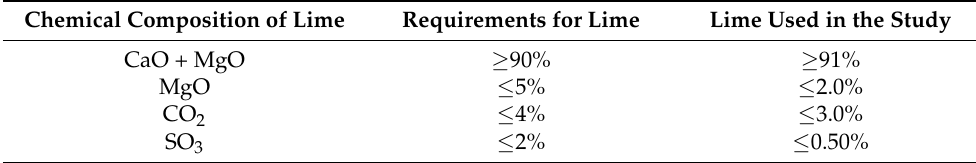
Table 2. Chemical composition of lime.